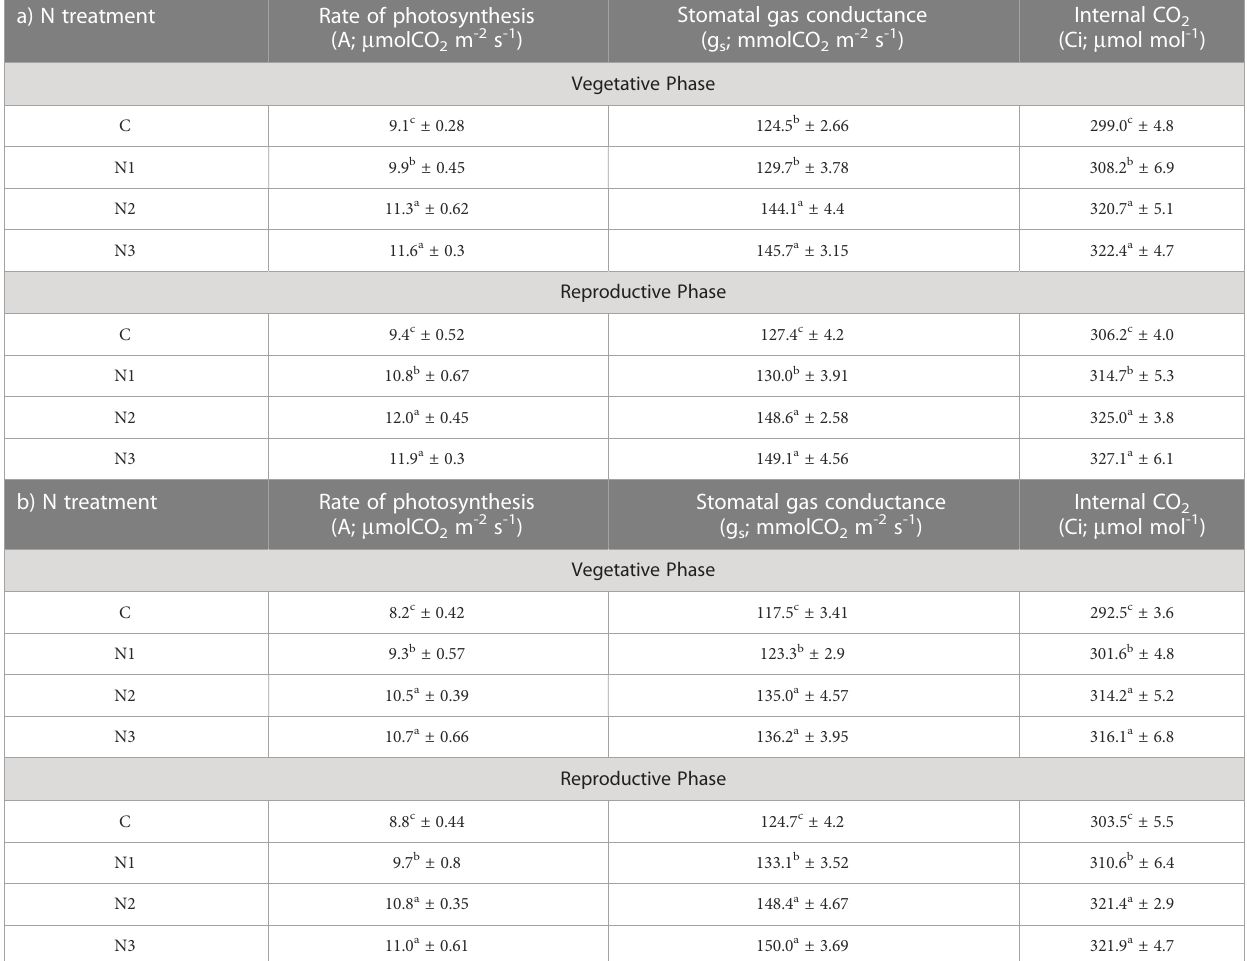
TABLE 3 Effect of N treatment (C, control; N1, recommended N dose; N2, 1.5-times recommended N dose and N3, 2-times recommended N dose) on physiological parameters of Dolichos lablab L. under EO 3 at vegetative stage and reproductive stage. Values are mean ± SE. a) Kashi Sheetal, b) Kashi